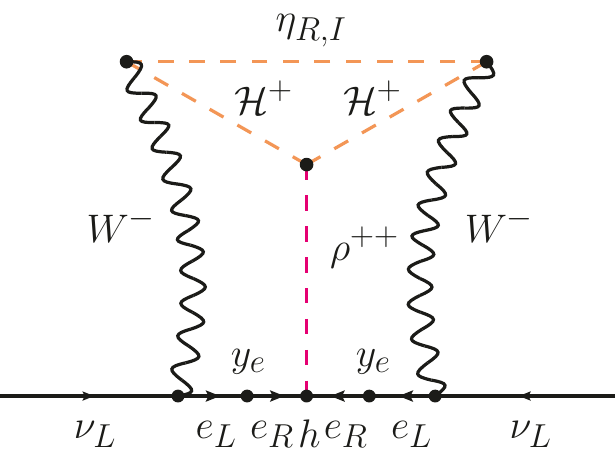
Figure 1 . 3-loop neutrino masses in the cocktail model. The inert doublet (cid:17) is split into its real and imaginary parts, (cid:17) 0 = 1 ( (cid:17) R + i (cid:17) I ), due to the scalar potential terms proportional to (cid:21) 5 . p 2 + + represent the singly charged scalars in the model, obtained after diagonalizing the mass 1 ; 2 H (cid:17) H matrix of the S + ; (cid:17) + f g